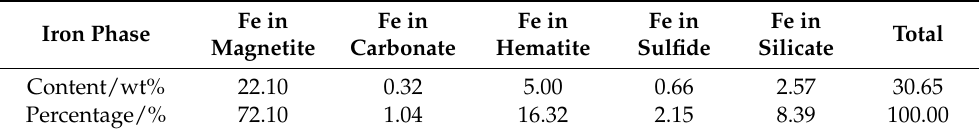
Figure 1. XRD pattern of the iron ore sample. Table 2. The iron phase composition of the iron ore sample.